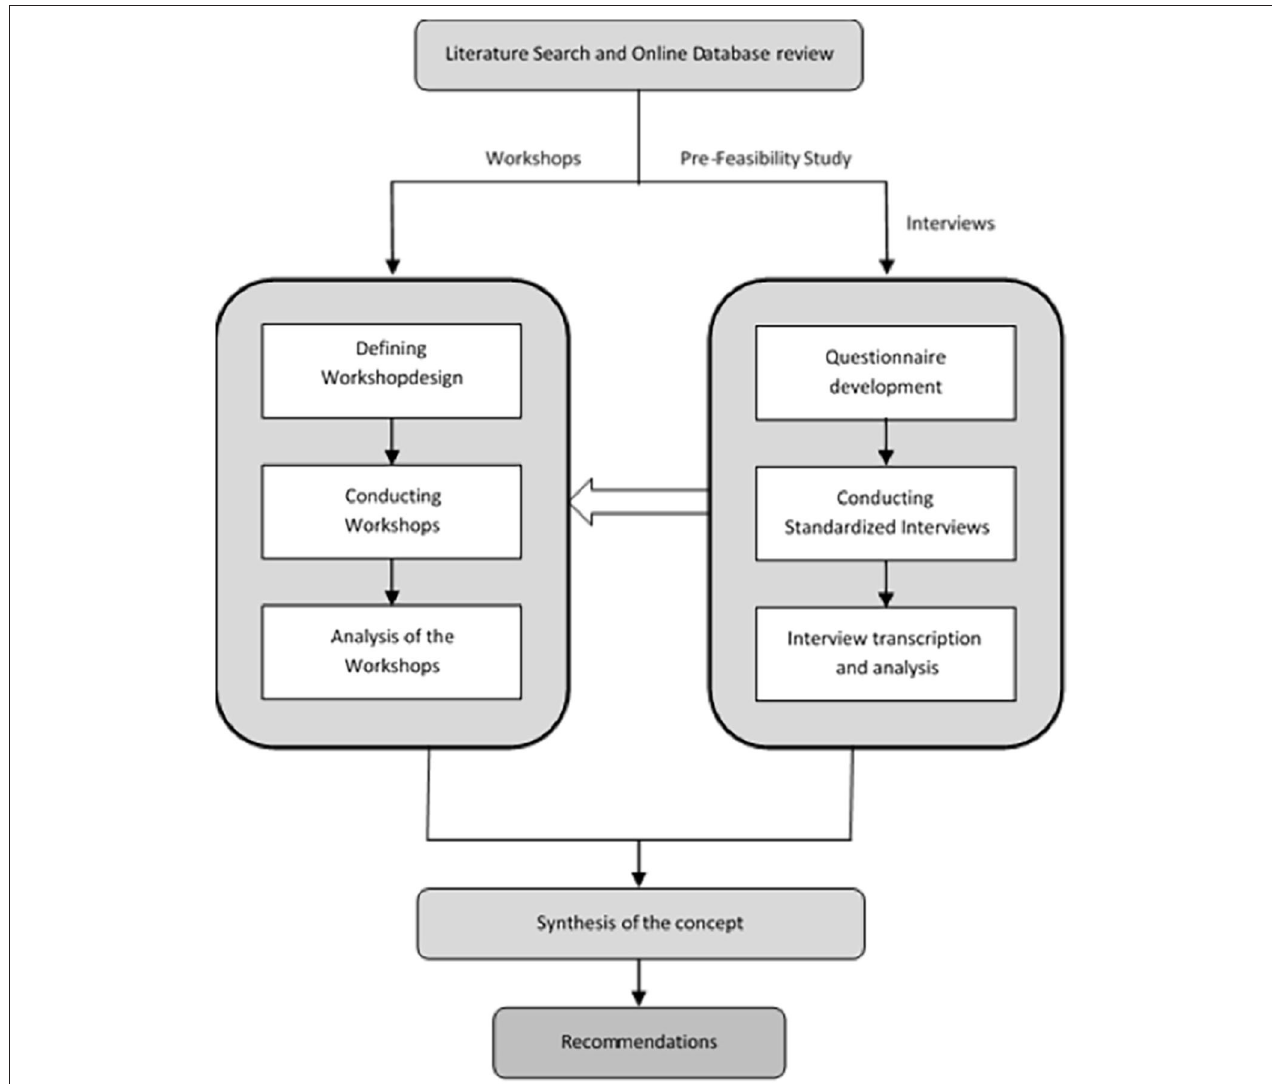
FIGURE 1 | The method to develop an integrated ecosystem for active and healthy aging in the reference site